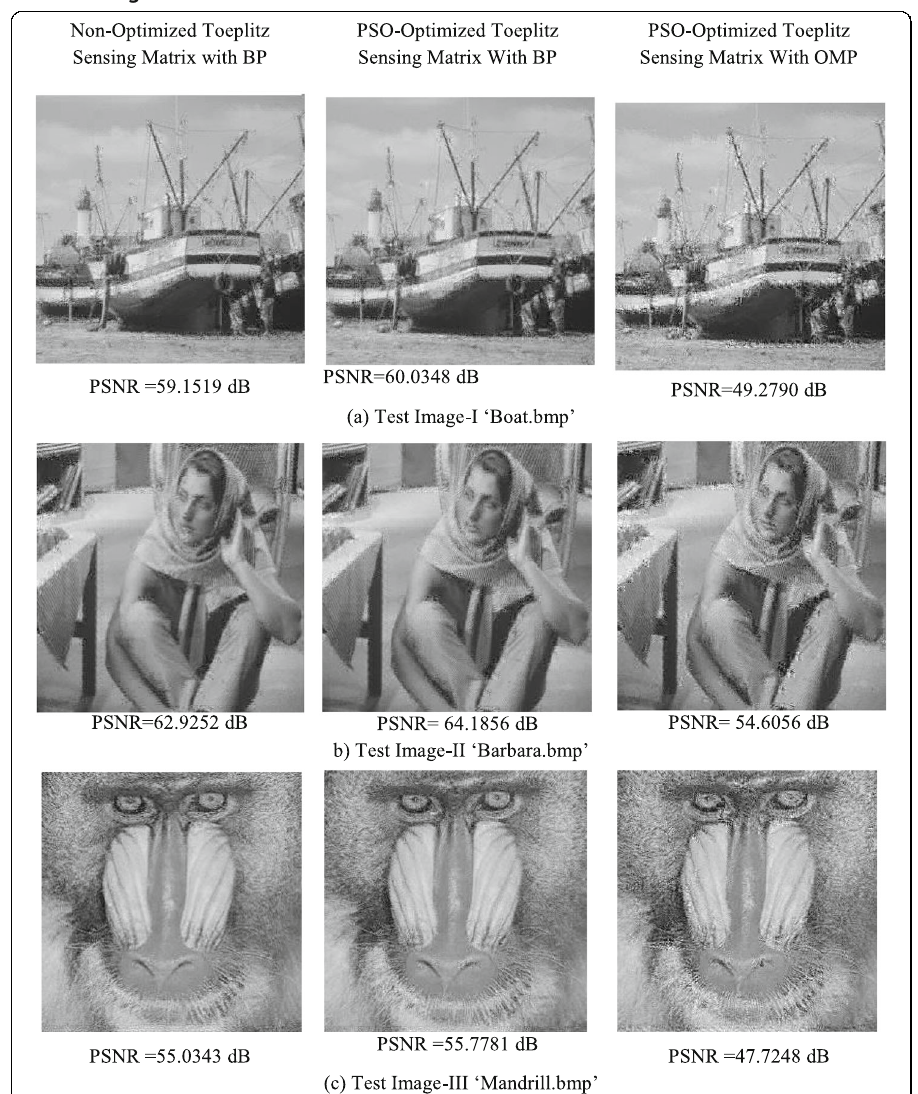
Fig. 18 Comparison between reconstructed test images using proposed PSO-optimized sensing matrix with BP and OMP algorithms, for CR=0.5. a Test Image-I “ Boat.bmp. ” b Test Image-II “ Barbara.bmp. ” c Test Image-III “ Mandrill.bmp